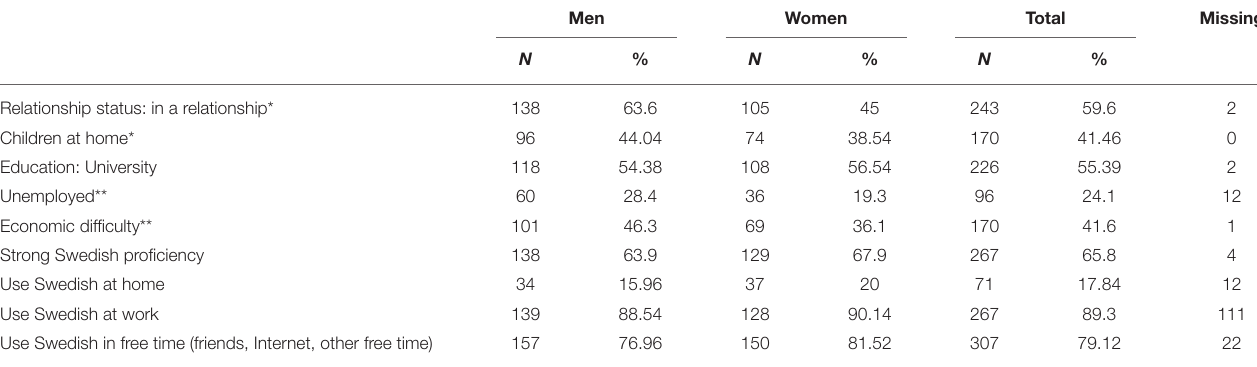
TABLE 2 | Social determinants, by gender ( N =